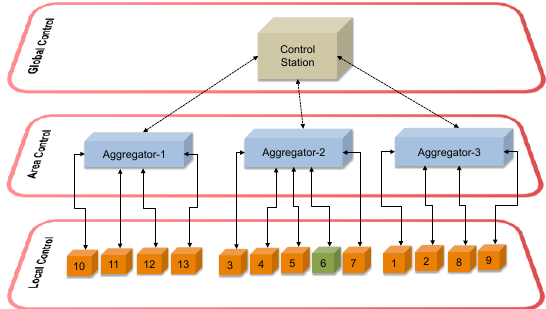
Figure 4. Proposed self-similar hybrid architecture implemented in the 13-node radial distribution